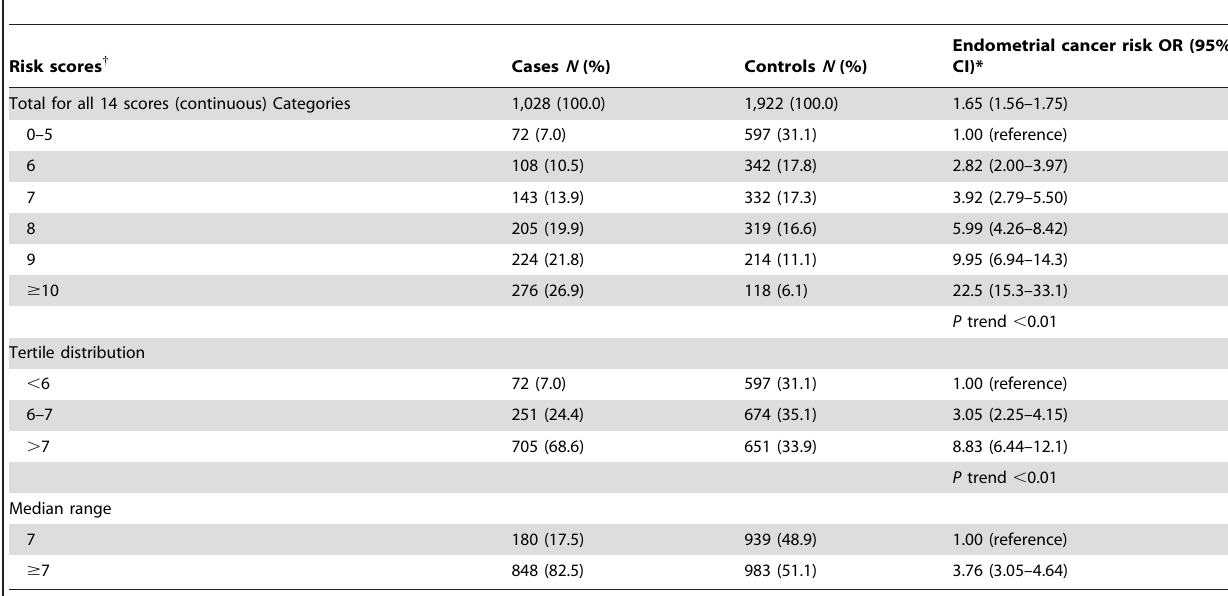
Table 2. Associations of risk scores for established risk factors with endometrial cancer risk, the Shanghai Endometrial Cancer Genetics Study